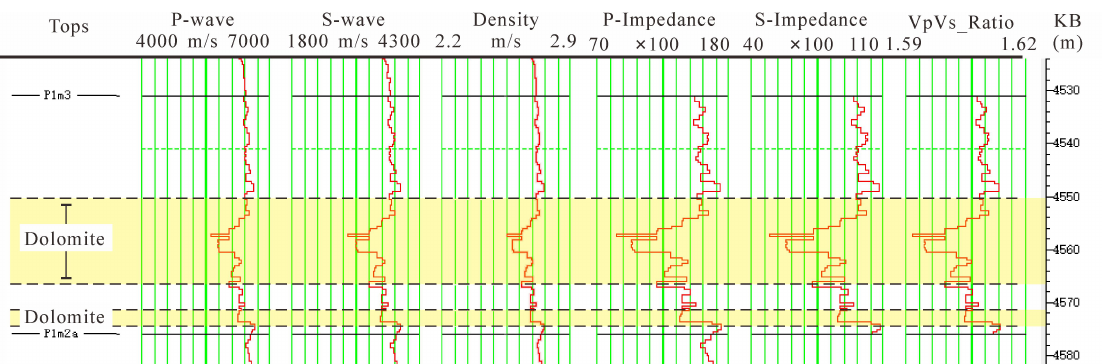
Figure 6. Logging response characteristics of well